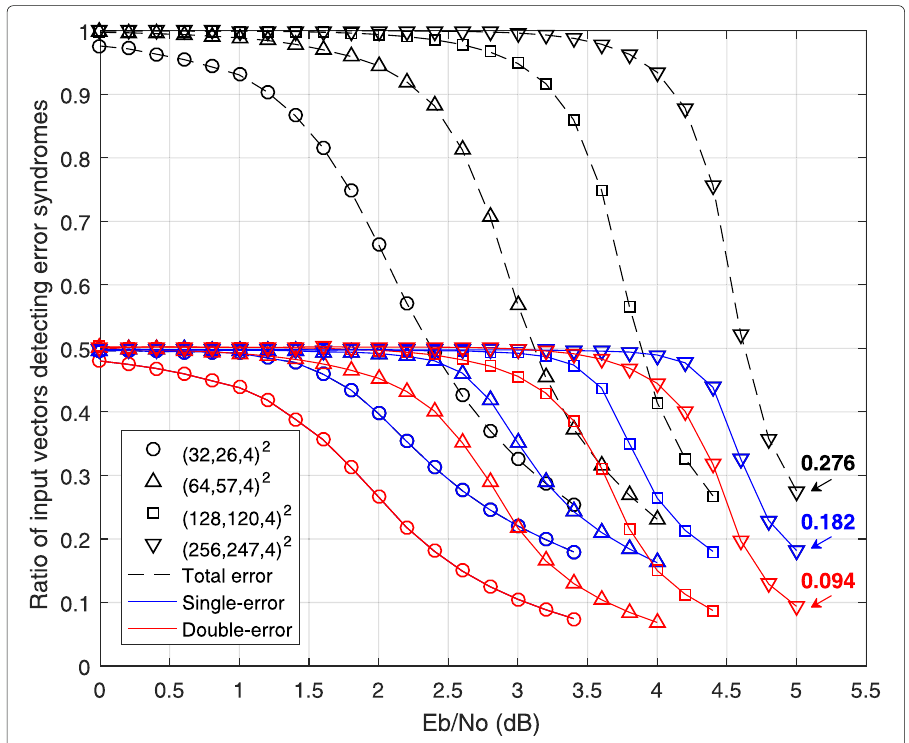
Fig. 2 Ratios of input vectors detecting error syndromes (black: total error, blue: single-error, red: double-error) according to the SNR increment during the TPC decoding based on the Chase-Pyndiah algorithm. We assumed that both the number of maximum iteration and LRBs as